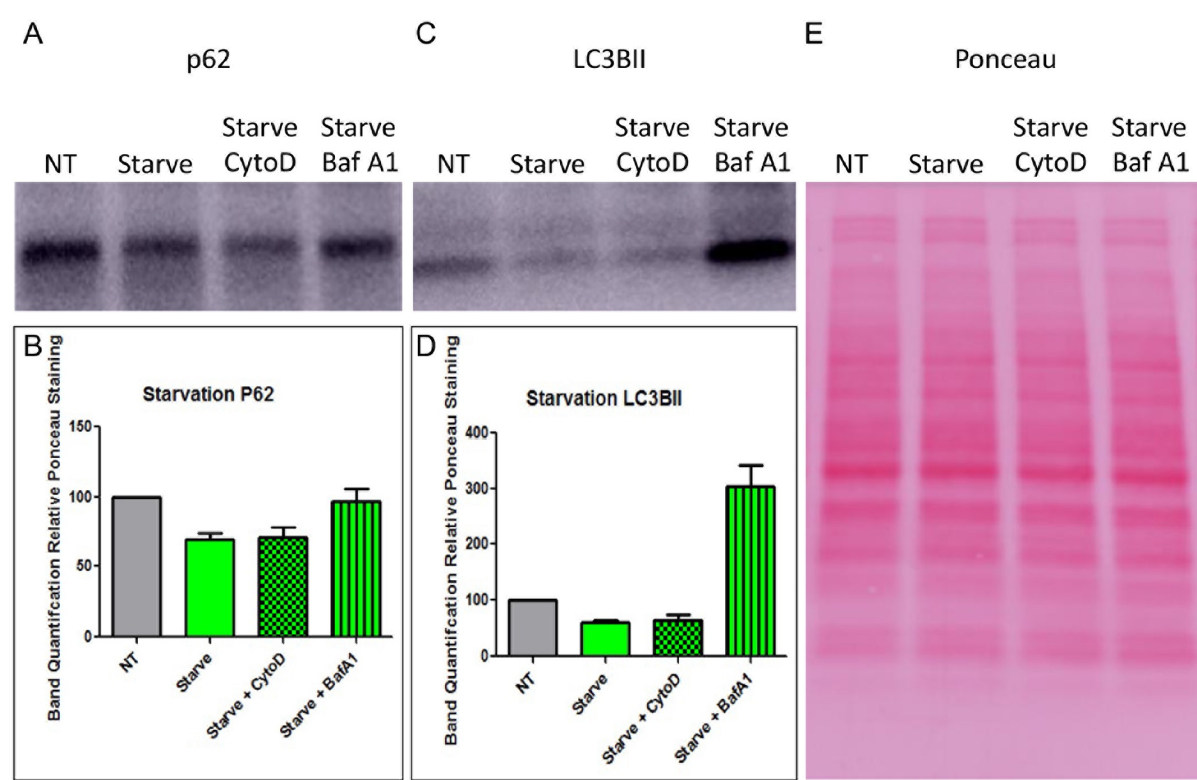
Figure 5. HBSS starvation results in activation of autophagic flux in MDCK-CAR Ex8 cells. MDCK- CAR Ex8 cells were starved in HBSS+/+ for 4 h and then treated with cytochalasin D or bafilomycin A1. The MDCK-CAR Ex8 cells were then washed thoroughly before performing Western blotting on the samples. Representative Western blot data of ( A ) anti-p62 treated and ( C ) anti-LC3BII treated blots as well as ( E ) Ponceau staining are shown. Band quantifications of ( B ) p62 bands relative Ponceau staining and ( D ) LC3BII bands relative to Ponceau staining are shown. Error bars represent SEM from 3 independent experiments each performed in quadruplicate. NT, non-treated.